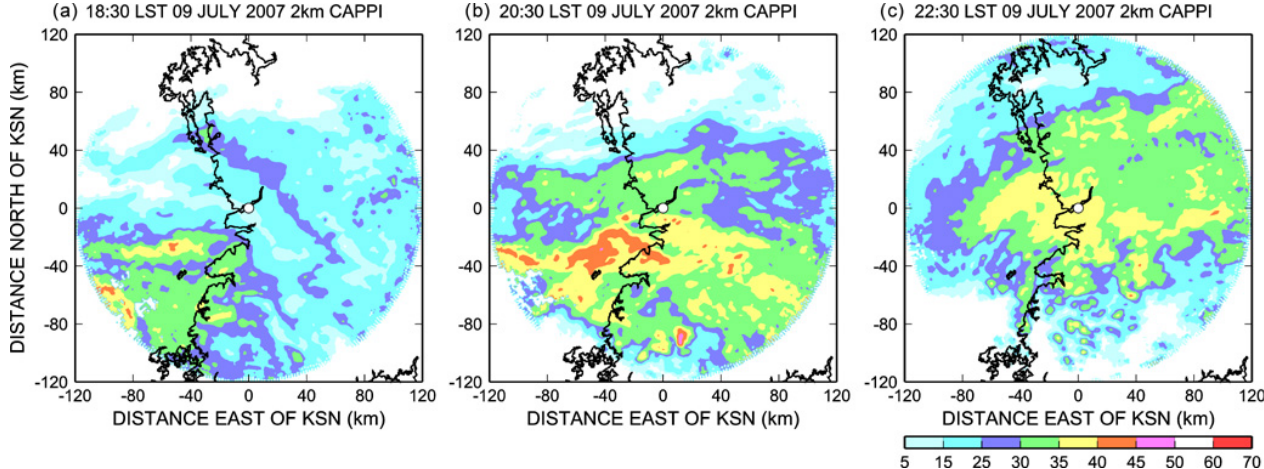
Fig. 10. Horizontal distribution of reflectivity at 2km a.s.l. for (a) 18:30LST, (b) 20:30LST, and (c) 22:30LST on 9 July 2007.